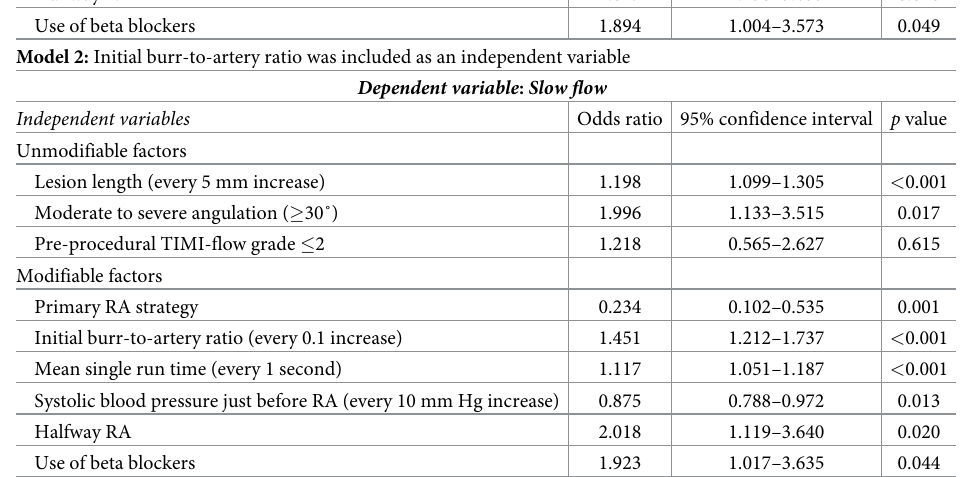
Model 2: Initial burr-to-artery ratio was included as an independent variable Dependent variable : Slow flow